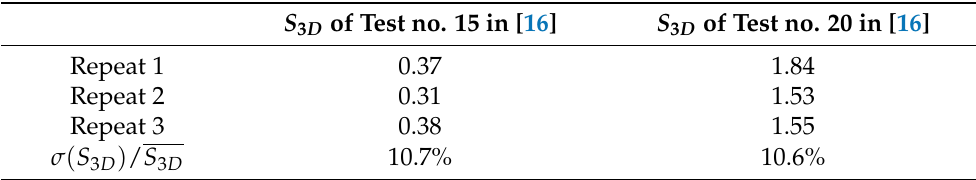
Table 10. S 3 D and σ ( S 3 D ) / S 3 D results from repeated tests in De Vos et al. (2012)